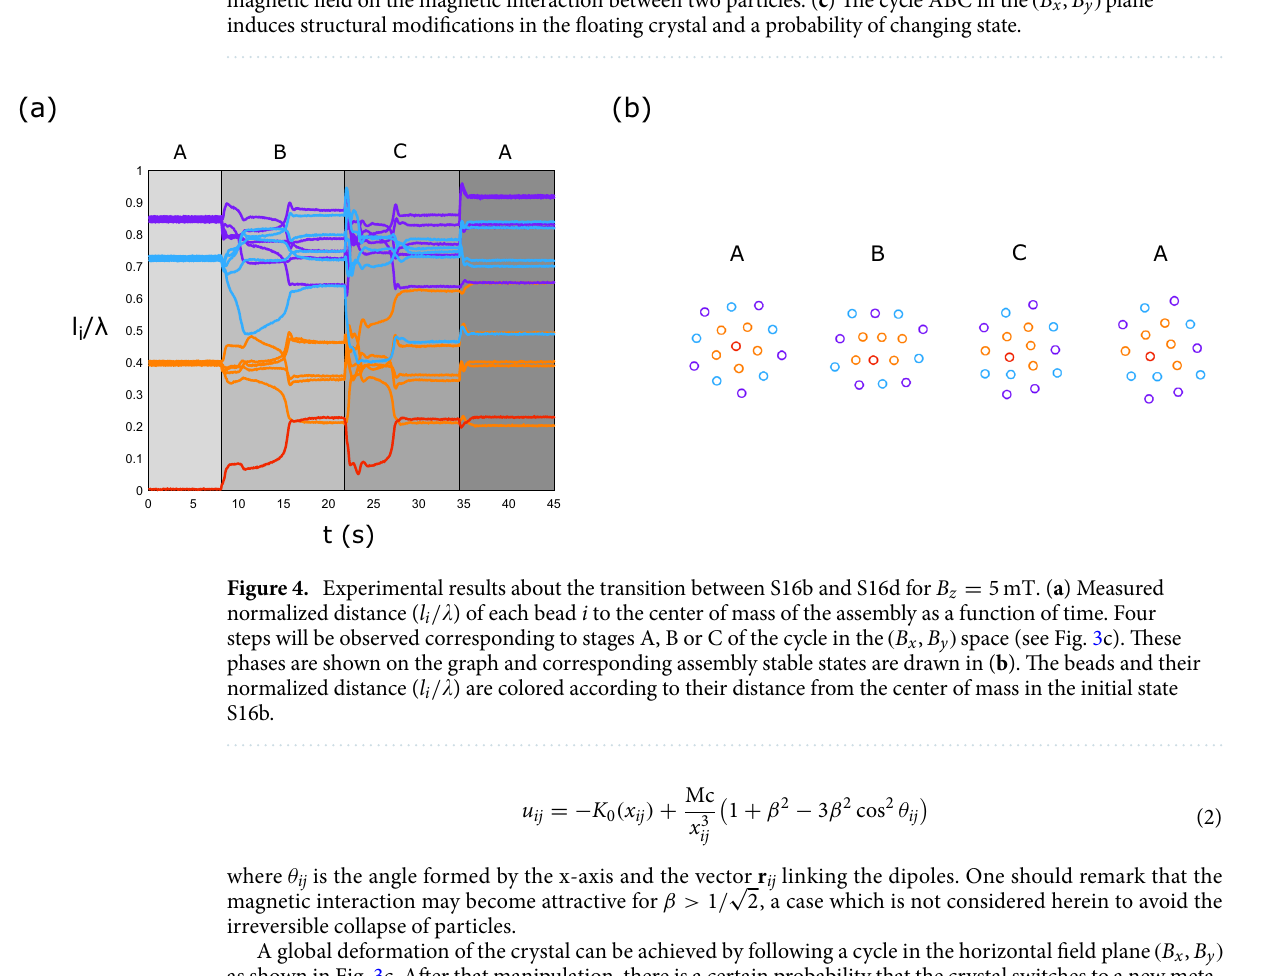
l i (cid:31) } containing the 16 beads relative distance l i divided by { l i l i (cid:31) } . The graph of the set { (cid:31) } as a {